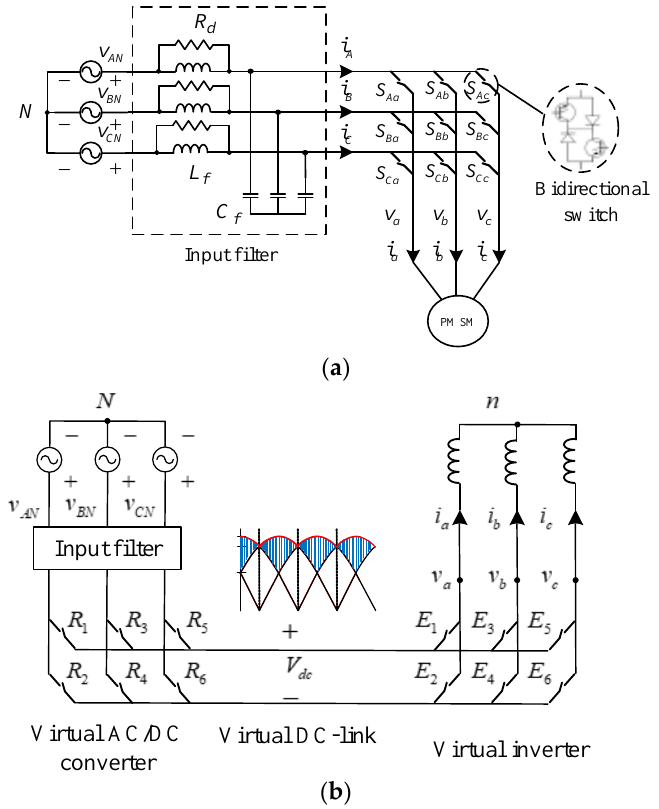
Figure 1. Matrix converter. ( a ) Main circuit, ( b ) equivalent circuit.